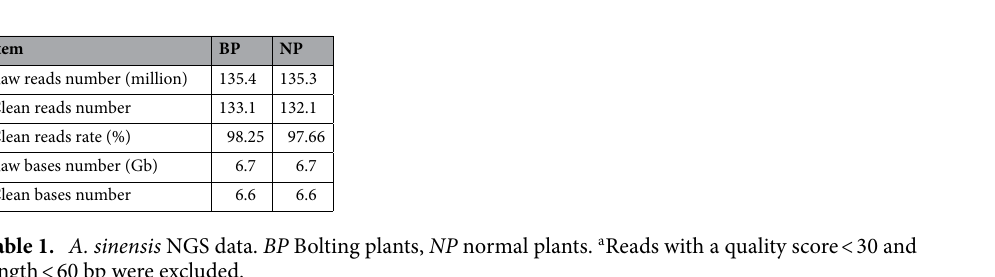
Figure 1. A. sinensis cultivated in Min County, Gansu Province, China. ( a ) Bolting plants (BP) and normal plants (NP) in the same growth period; The whole growth period of A. sinensis typically consists of 3 years, including of 2 years vegetative growth, followed by flowering and seed set from the third year onwards. In early bolting ecotypes, flowering occurs prematurely in the second year. ( b ) Sampling position. Shoot tips of A. sinensis under the same growth conditions were collected before bolting.